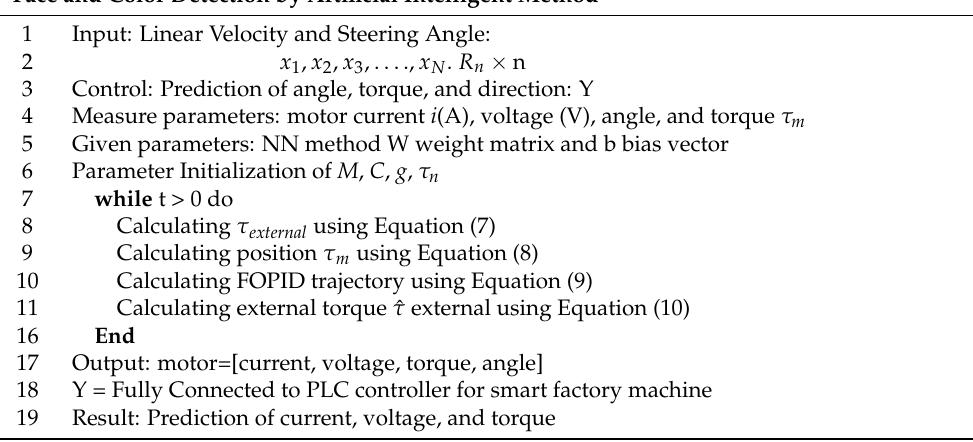
Table 2. Intelligent robot manipulator motor control method with object recognition for light-out factory